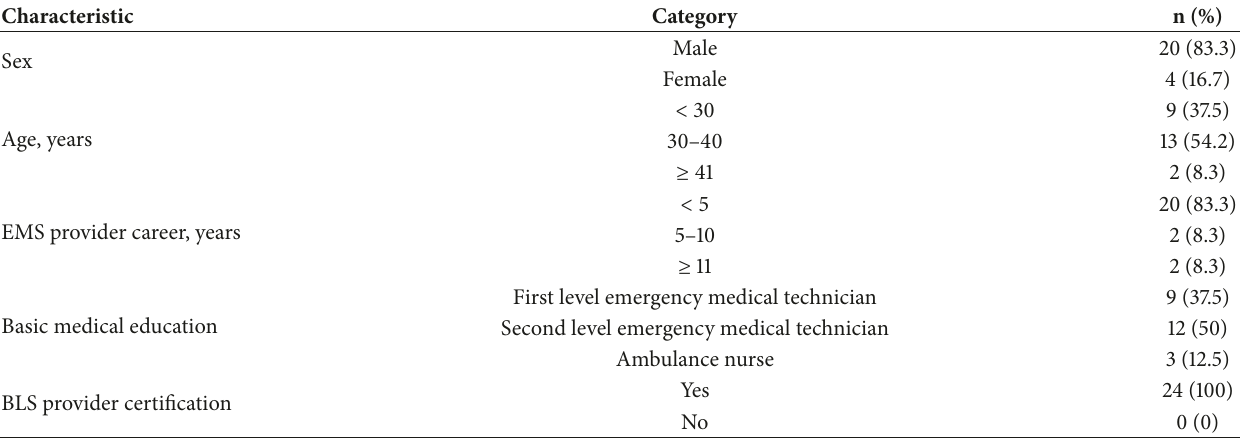
Table 1: Characteristics of the 24 professional EMS providers who participated in the study.